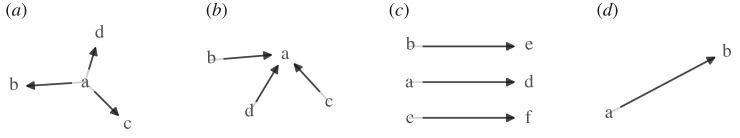
Examples of interchangeable networks of varying vertex and edge count with identical effectiveness limit, ε = 1 − λ, in the absence of heterogeneity of characteristics.